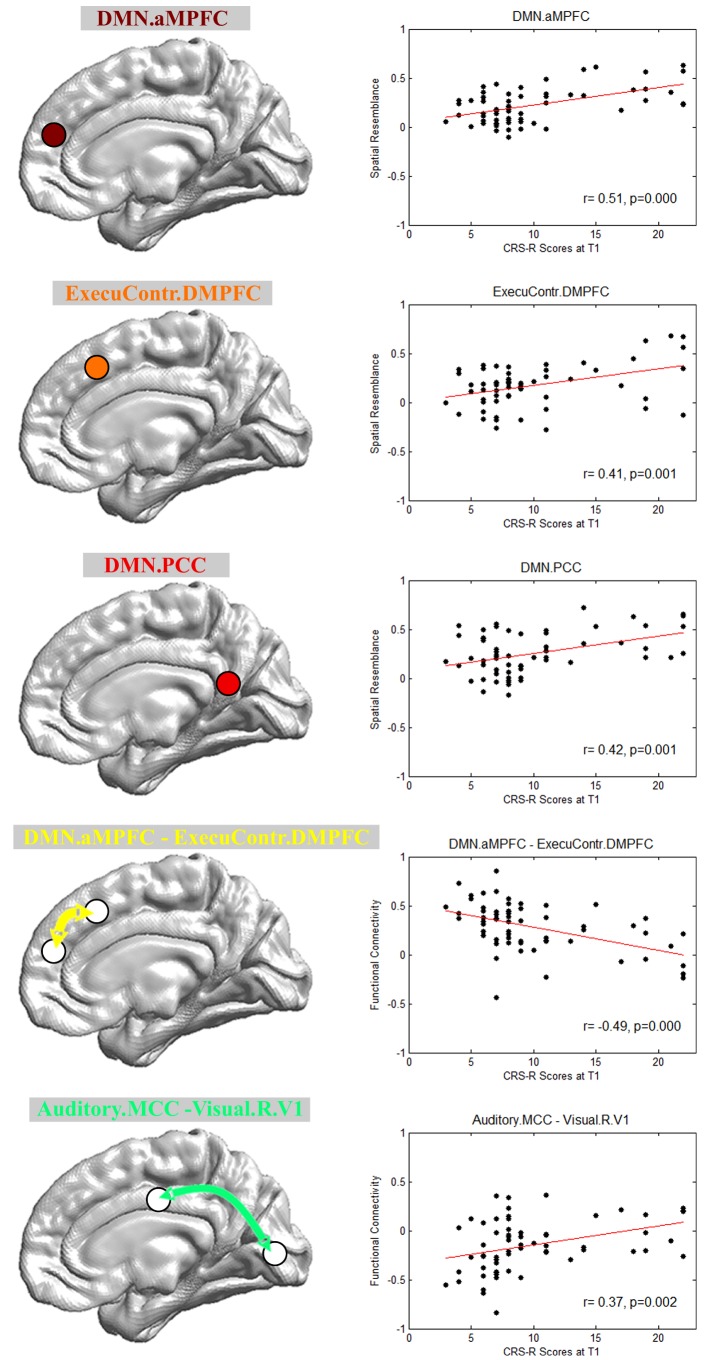
Imaging features involved in the prognostic regression model.DMN.aMPFC, anterior medial prefrontal cortex in the default mode network; DMN.PCC, posterior cingulate cortex/precuneus in the default mode network; ExecuContr.DMPFC, dorsal medial prefrontal cortex in the executive control network; Auditory.MCC, middle cingulate cortex in the auditory network; Visual.R.V1, right lateral primary visual cortex in the visual network. DMN.aMPFC—ExecuContr.DMPFC: the functional connectivity between DMN.aMPFC and ExecuContr.DMPFC; Auditory.MCC—Visual.R.V1: the functional connectivity between Auditory.MCC and Visual.R.V1.